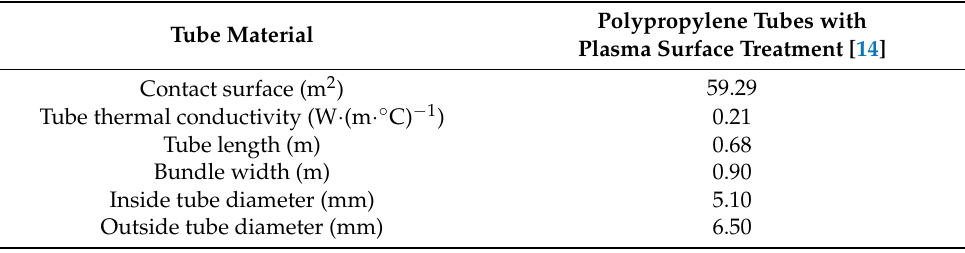
Table 2. Specifications of the air-solution